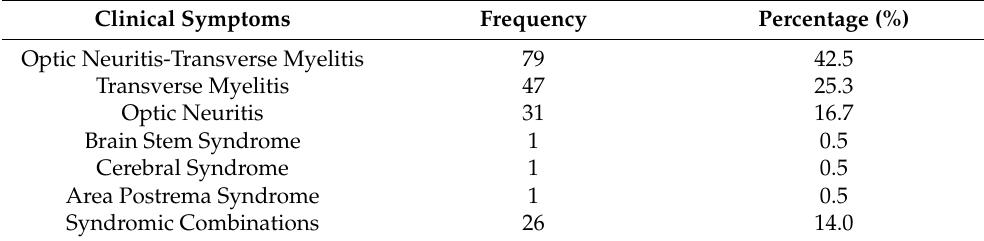
Table 3. Relative frequency of NMOSD clinical symptoms in Central America and the Caribbean